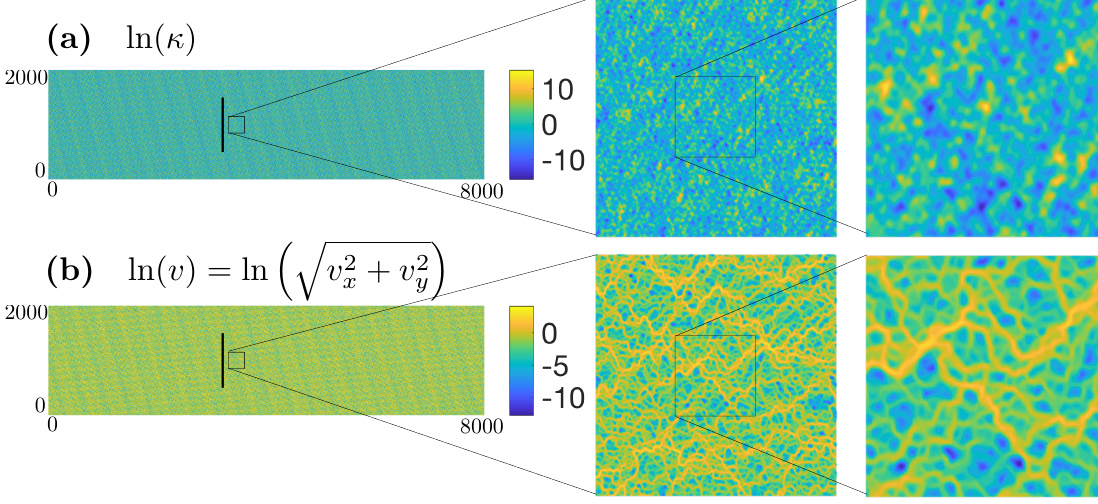
Figure 1. ( a ) The natural log of the permeability field κ and ( b ) the natural log of the absolute value of v 2 x + v 2 y , where v x and v y are the velocity fields in the horizontal and vertical flow the velocity v = directions, respectively. The solid black line on each of the fields indicates the location of the solute (cid:113) line injection and the small squares indicate regions which we have zoomed in on so the flow features could be seen more clearly on the right side of the